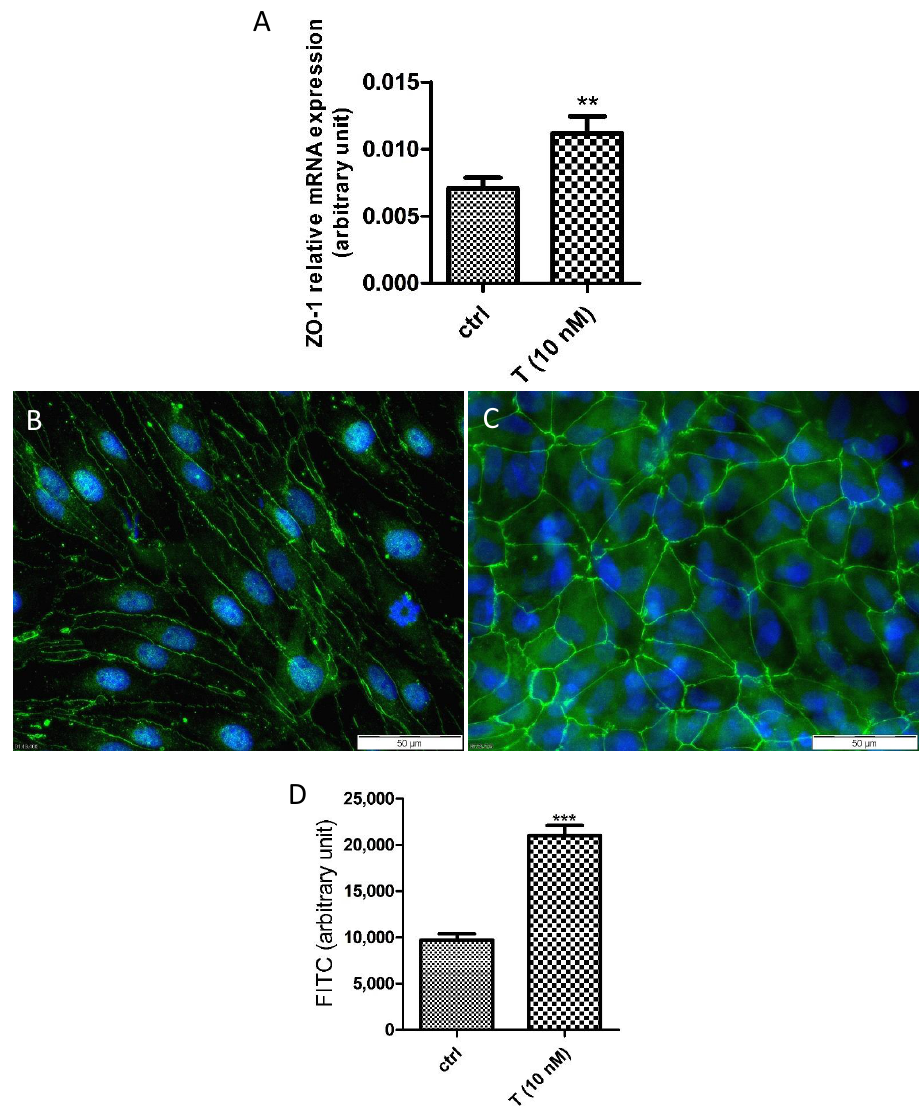
Figure 10. Effects of testosterone (T) on ZO-1 mRNA expression ( A ) and protein presence ( B – D ). PASC1 (2 × 10 5 cells/well) were treated with T for 24 h. The ZO-1 mRNA expression was significantly increased by the T treatment ( A ) and compared to the untreated cells ( B ). A stronger protein presence was observed between cell-to-cell contacts in T-treated cells ( C ). Quantification showed a significant increase ( D ). DAPI was used to stain the nuclei (blue). Each bar represents the mean ± SEMs of three independent experiments performed in duplicates. The unpaired t -test was used for statistical analysis; ** p < 0.01; *** p <